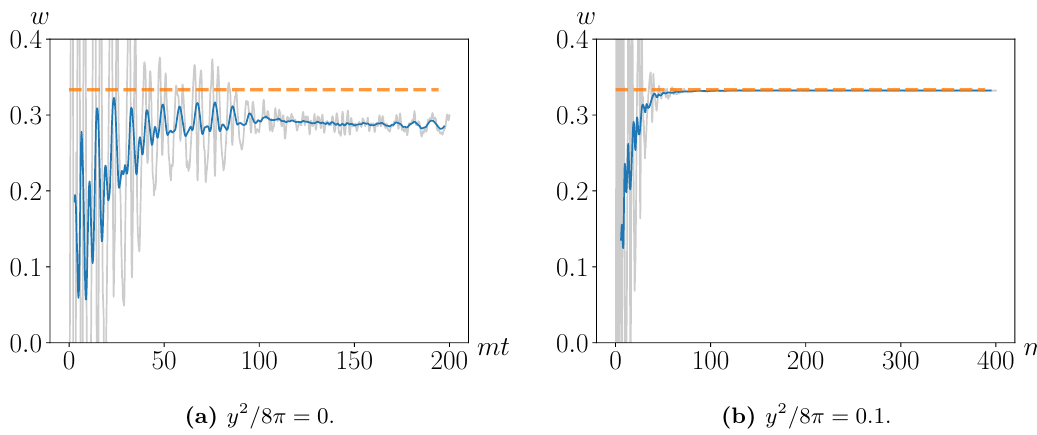
Figure 5. Time evolution of the equation of state w for b = 0 . 9 , m = 10 − 6 M pl , Φ 0 = f = M pl , q 0 = 200 and y 2 / 8 π = 0 or 0.1. The gray curves are the raw simulation results, and the blue curves are the time average to remove the rapid oscillations. The dashed orange horizontal line is drawn at w = 1 / 3 . When y 6 = 0 , the system energy density is dominated by the radiation-like fermion fluid, thus w rapidly approaches 1 / 3